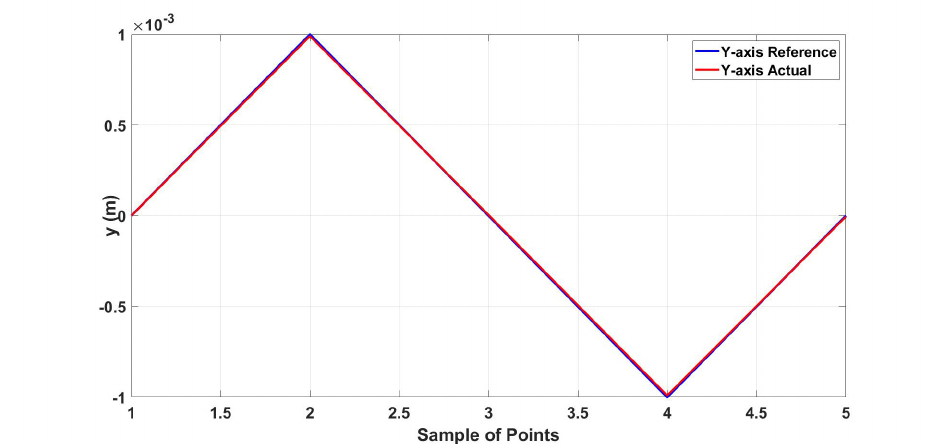
Figure 10. Actual and reference position of the diamond trajectory in the y-axis.